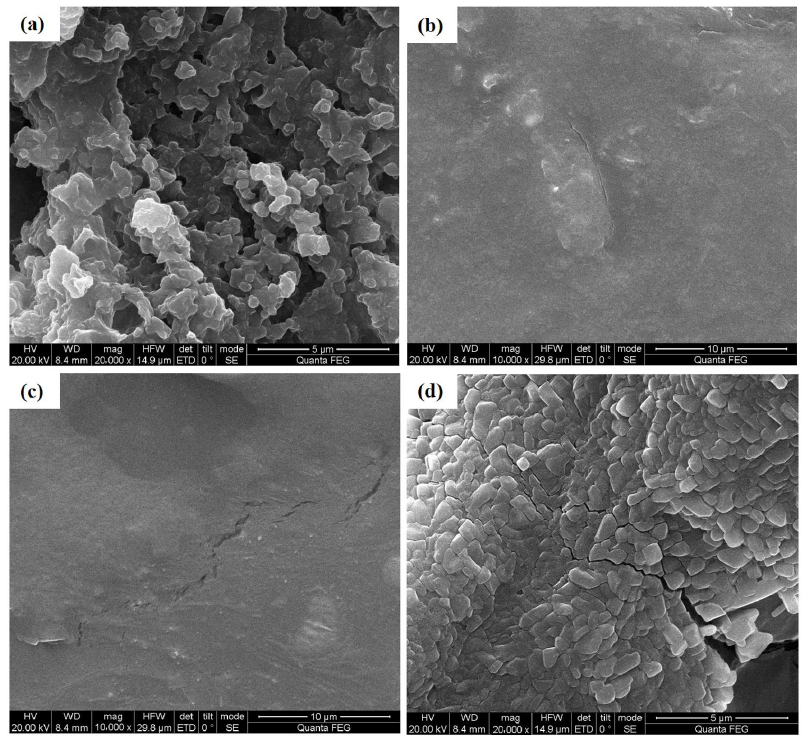
Figure 5. The scanning electron microscopy of NRFPs. ( a ) CNRFP; ( b ) NRFP-1; ( c ) NRFP-2; ( d )